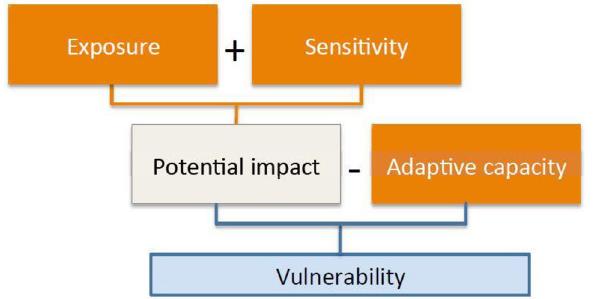
Figure 2. Conceptual model of the vulnerability components ( Source: FAO,